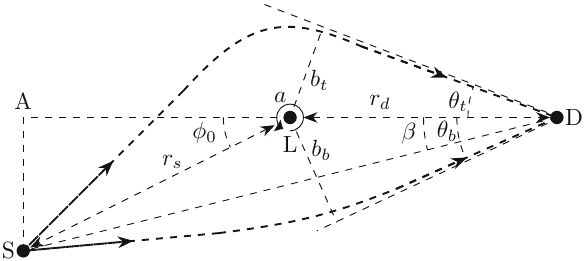
Fig. 1 The GL in an SAS spacetimes. S, L, D are the source, lens and detector respectively. b t and b b are the impact parameters for the top and bottom paths. beta is the source’s angular position assuming that the gravitational center was not present. The spin angular momen- tum of the lens in this illustration is anticlockwise. We choose the sign (cid:12) = sign (φ ) = sign (β) = + 1 (and − 1) when φ β are counter- 0 0 and clockwise (and clockwise) against the observer-lens axis